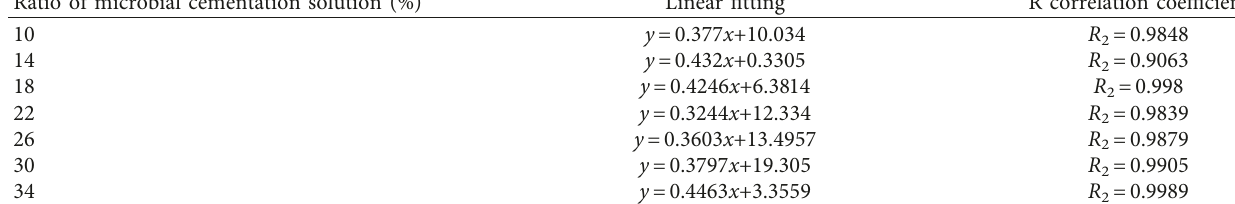
Table 1: Linear fitting of vertical pressure and shear strength of loess specimen with different ratios of the microbial cementation solution. Ratio of microbial cementation solution (%)